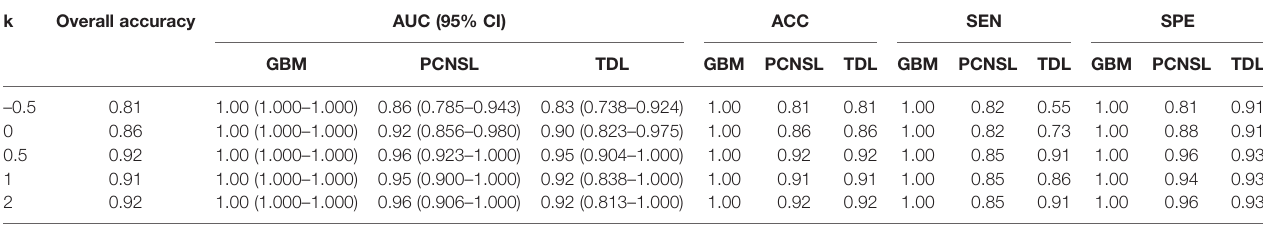
TABLE 2 | Diagnostic performance at different k